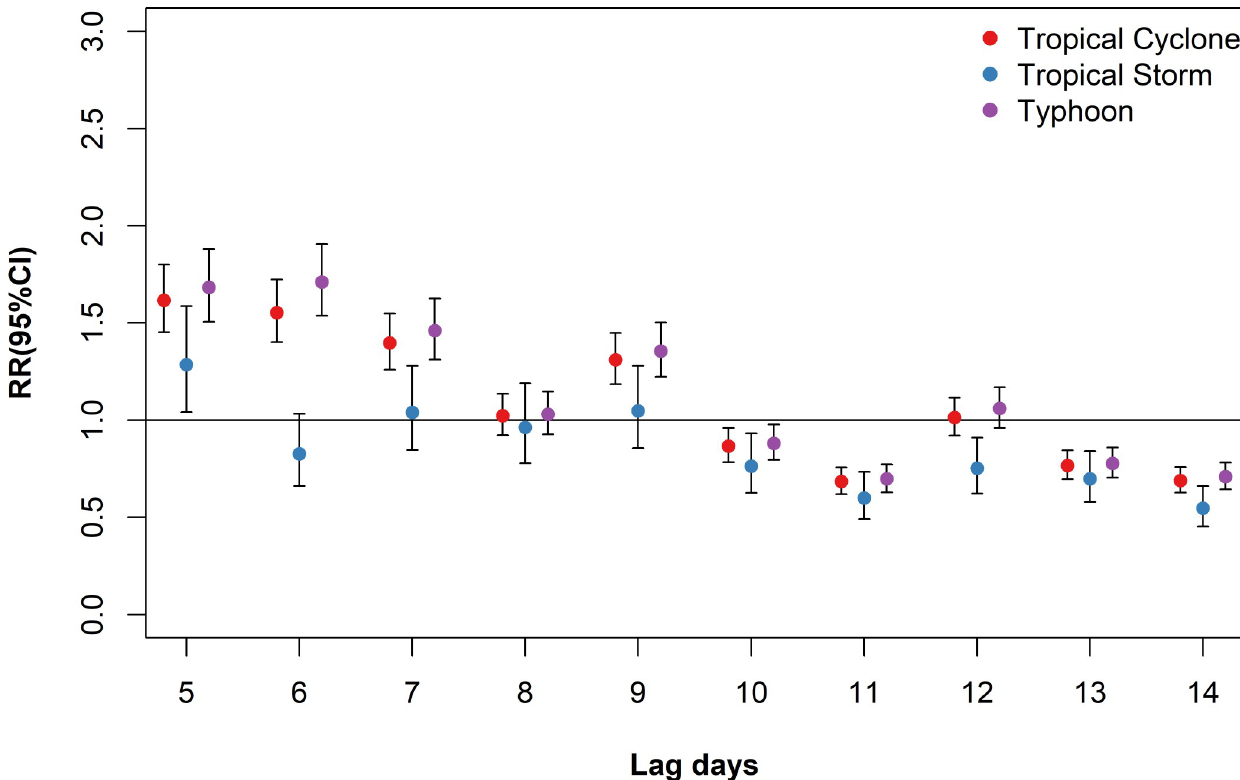
Fig 3. Association between tropical cyclones and risk of DF incidence by intensity grades on lag 5–14 days in the PRD during the study period.